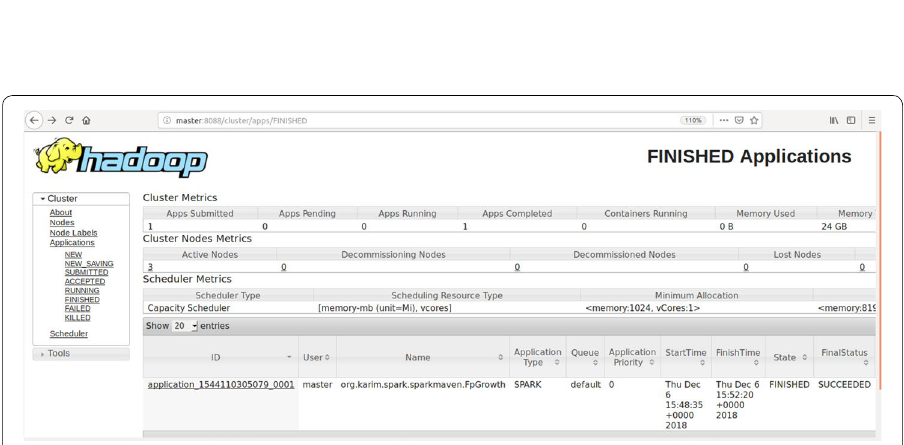
Fig. 13 Yarn Web UI: It monitors the application submission ID, the user who submitted the application, its status, and other useful information about the execution of Spark